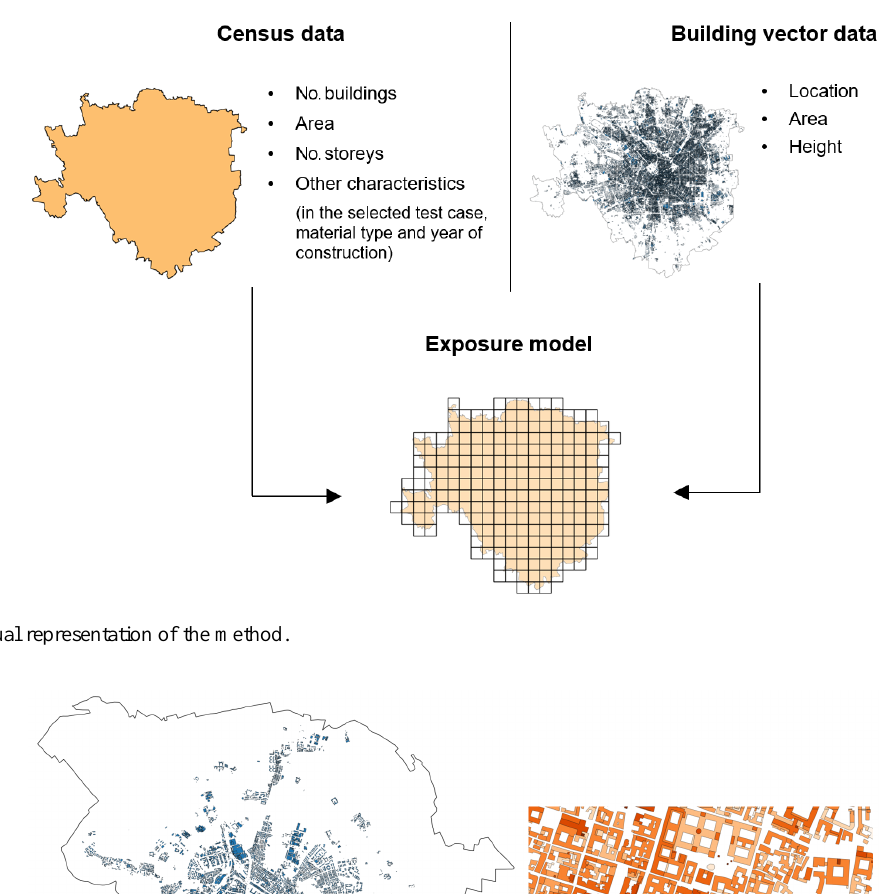
Figure 3. Left: building footprints for the municipality of Pavia. Right: highlight of a part of the municipality, with buildings classified by height, from lower (light orange) to higher (dark